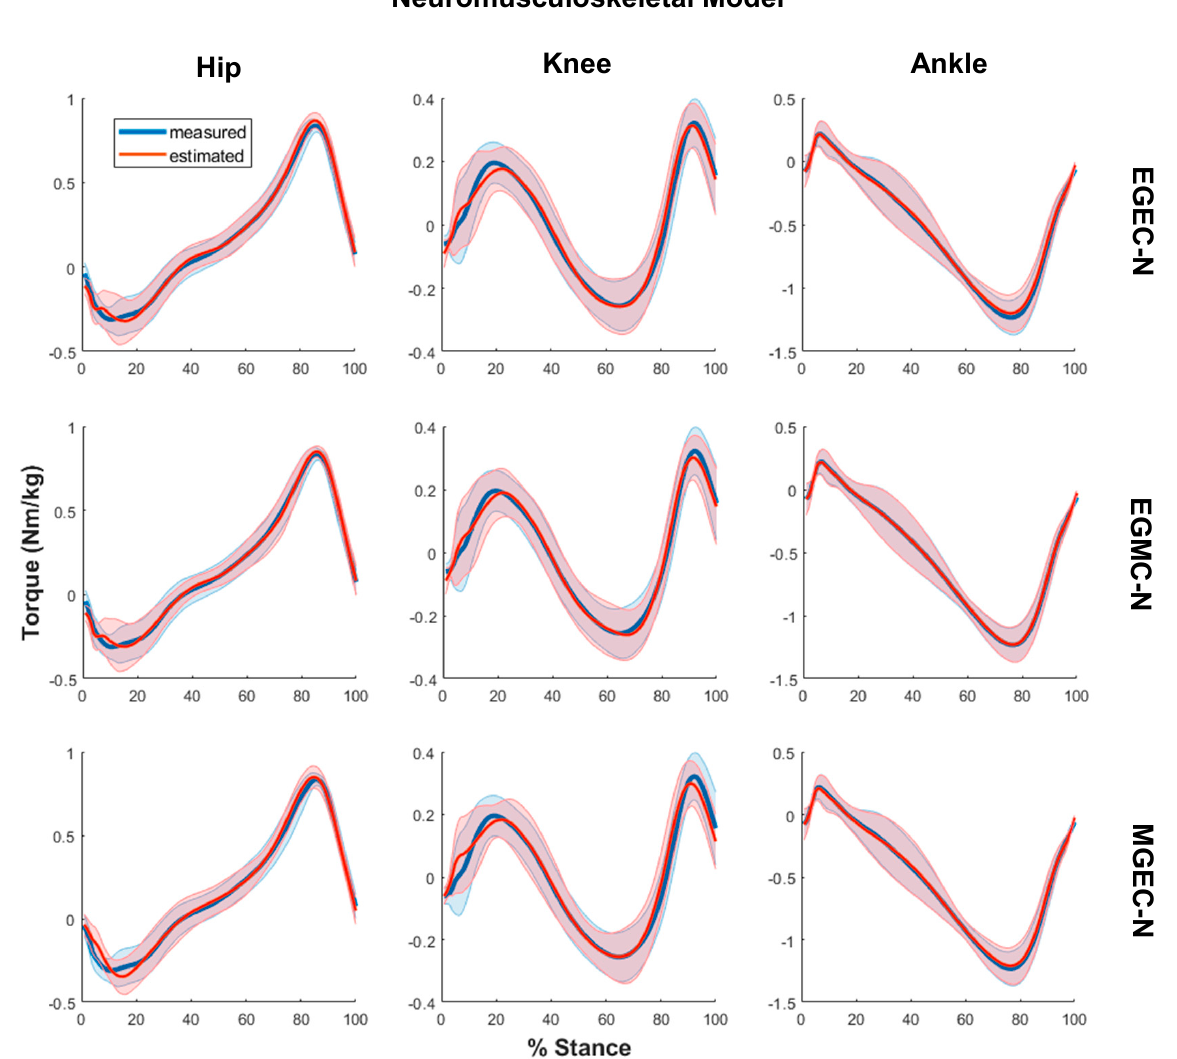
Figure 5. Measured (blue) and estimated (red) joint torques via neuromusculoskeletal modelling for hip ( left column ), knee ( middle column ) and ankle ( right column ) for three conditions: estimated both GRF and COP (EGEC-N) ( top row ), estimated GRF only (EGMC-N) ( middle row ) and estimated COP only (MGEC-N) ( bottom row ) averaged across all the trials and subjects. Torques were normalised with respect to body mass. Data were plotted in percent of stance phase from heel strike to toe-off. Shaded area represents one standard deviation of the subject means.